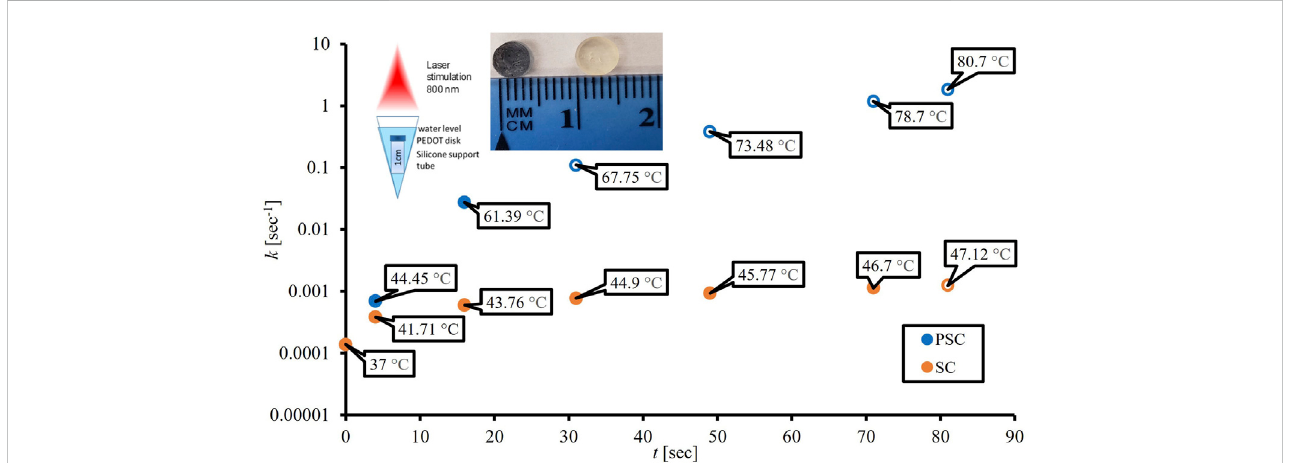
In fl uence of 3 W laser application times (sec) on cell death rates (sec − 1 ) from the van Asselt and Zwietering model for silicone (SC) and PEDOT-infused silicone (PSC) with open circles representing points below the 1E+06 CFU/mL survival analysis threshold. From left to right, the fi rst insert image shows the experimental set-up for the disk materials to ensure their orientation, distance from the laser and depth of water covering the disk. The second insert image shows the color differences between silicone (optically transparent) and PEDOT nanoparticle-doped silicone (dark blue).